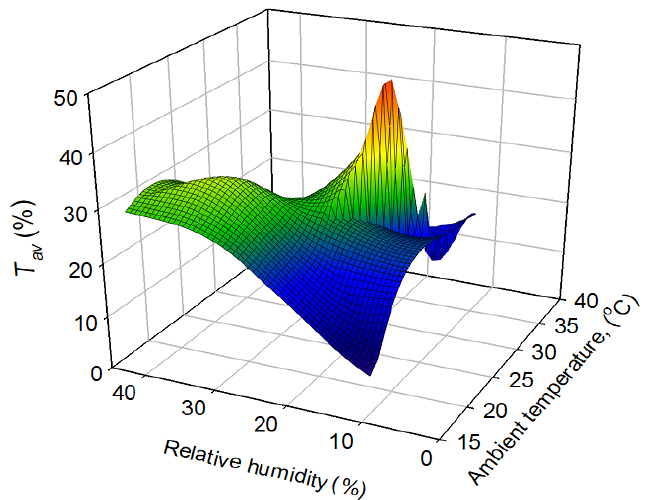
Figure 10. Three-dimensional plot for the average transmittance of the four covers ( T av %) as a function of the monthly averages of the ambient air temperature and relative humidity during the exposure time.